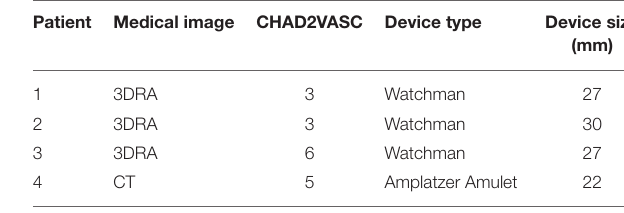
TABLE 1 | Patient and device